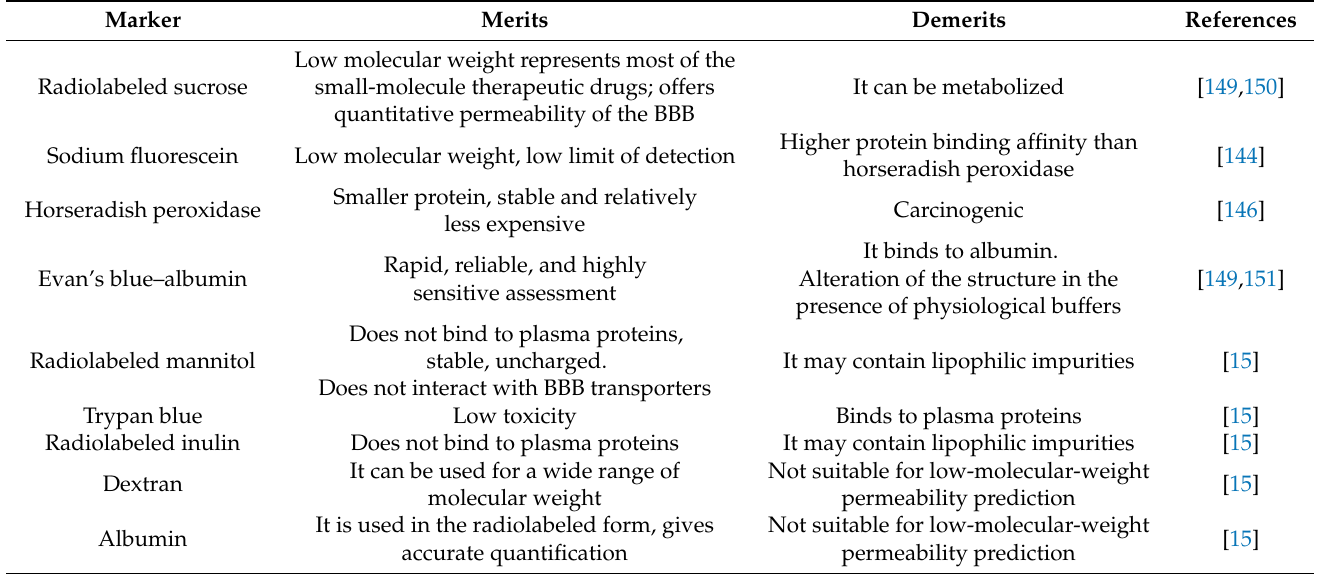
Table 3. Different markers used for the BBB permeability and their application with